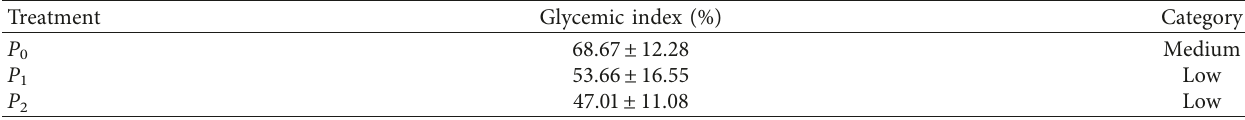
Table 4: Cookies with tempeh gembus flour substitution’s glycemic index. Treatment